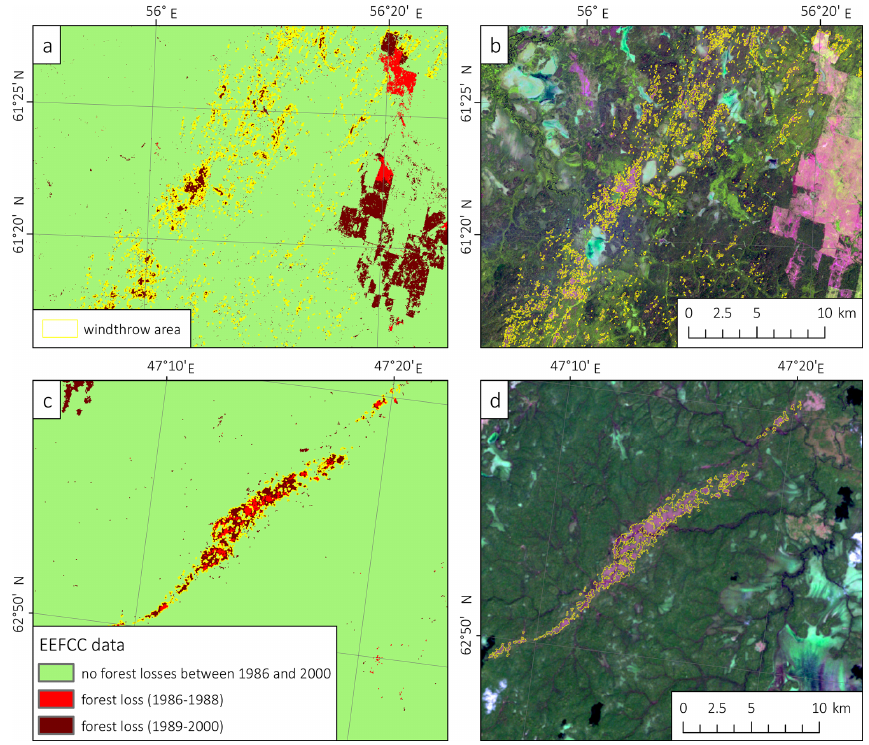
Figure 4. Delineation of (a, b) storm- and (c, d) tornado-induced windthrows occurring on 4 July 1992 and 24 July 1988, respectively, based on (a, c) the EEFCC dataset and (b, d) its subsequent verification by the Landsat images shown in the RGB combination of the TM5 (1.65µm), TM4 (0.85µm), and TM3 (0.66µm) spectral